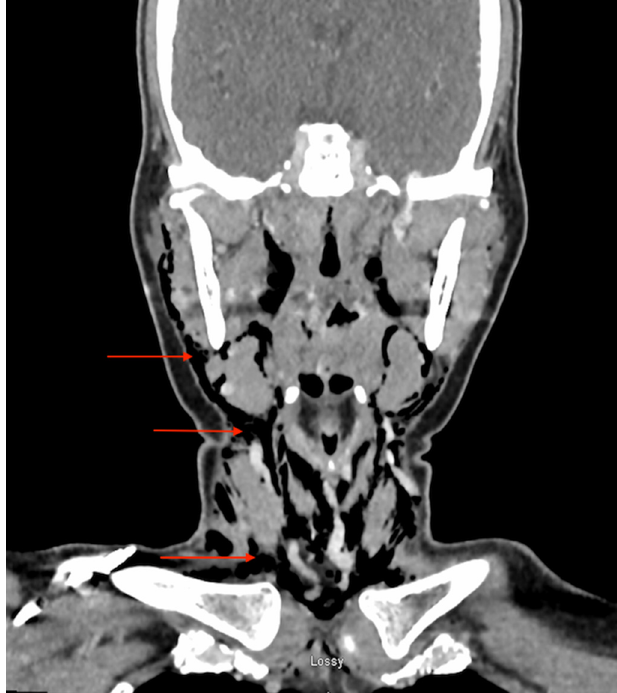
Fig. 1. Frontal head computed tomogram. Air accumulation under the skin pushing the buccinator muscle inside the right side with bilateral maxillary sinus thickening.